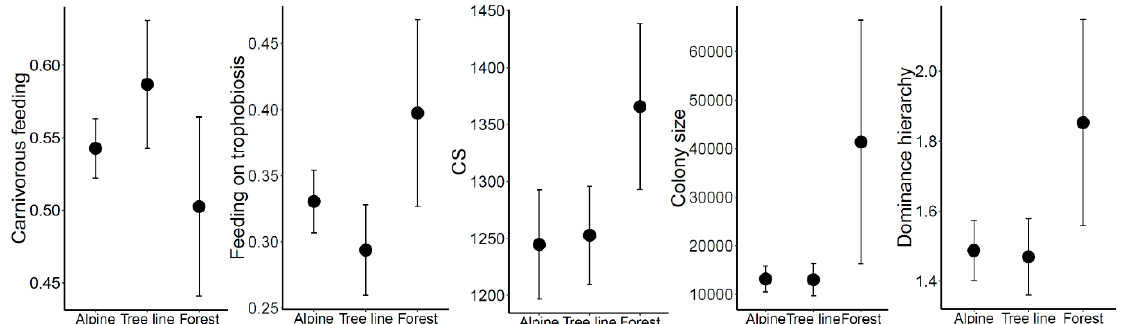
Figure 6. Plots of community weighted means and their 95% confidence intervals of some important functional traits of ant